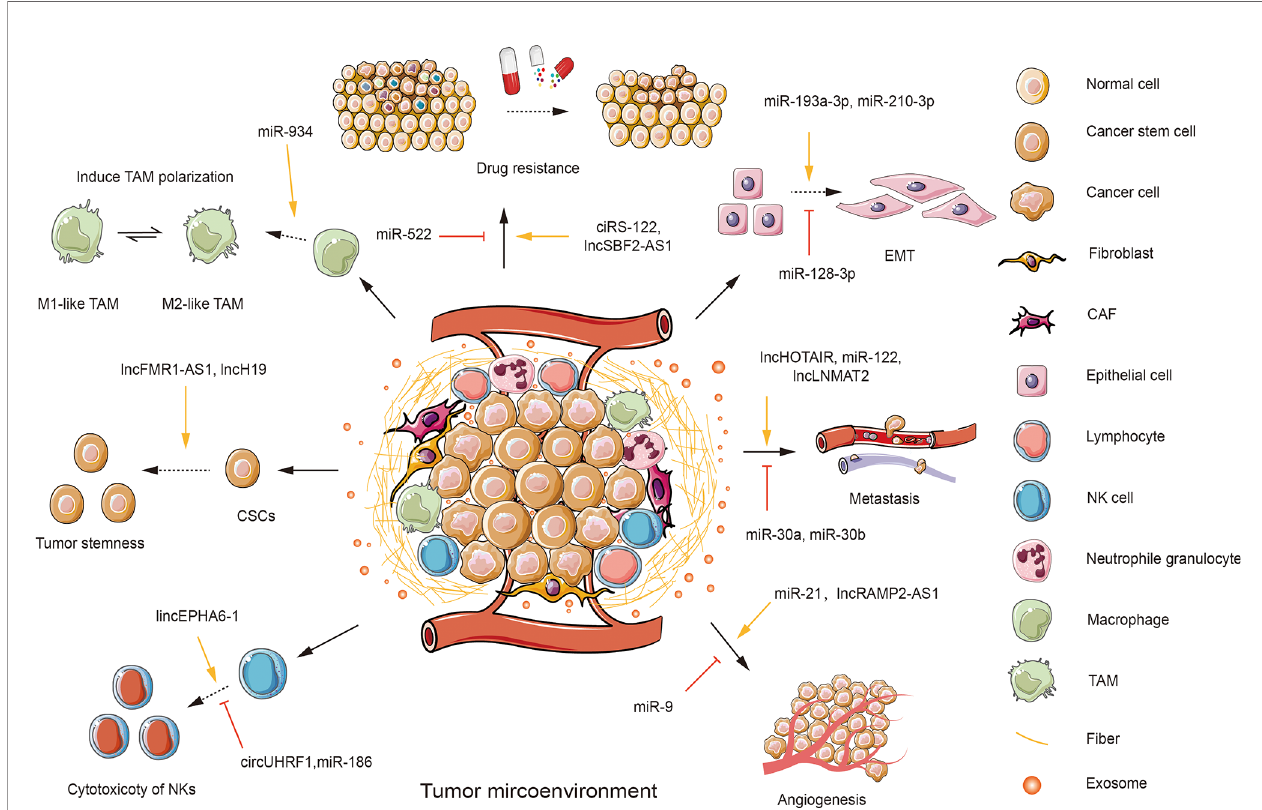
FIGURE 2 | An overview of the roles of exosomal ncRNAs in the tumor microenvironment (TME). TME is composed of various components, including stromal cells, such as fi broblasts; immunity cells, such as T and B lymphocytes, natural killer cells (NKs), neutrophile granulocytes, macrophages; cancer cells; cancer stem cells (CSCs); cancer-associated cells, such as cancer-associated fi broblasts (CAFs) and tumor-associated macrophages (TAMs); and other in fi ltrated biomolecules, such as exosomes. Tumor cells could transfer functional exosomal ncRNAs to regulate the behaviors of recipient cells in the TME. Tumor-derived exosomal miR-934 can induce the polarization of TAMs. Several exosomal ncRNAs can suppress the cytotoxicity of NKs (e.g., circUHRF1 and miR-186). While some exosomal ncRNAs are shown to enhance the cytotoxicity of NKs (e.g., lincEPHA6-1). Some exosomal ncRNAs (e.g., lncFMR1-AS1 and miR-454) can enhance tumor stemness. Additionally, a few exosomal ncRNAs are involved in the regulation of tumor progression. Some exosomal ncRNAs can promote (e.g., miR-21 and lncRAMP2-AS1) or inhibit tumor angiogenesis (e.g., miR-9). Tumor-derived exosomes can transfer exosomal ncRNAs to induce (e.g., lncHOTAIR and miR-122) or suppress (e.g., miR-30a and miR-30b) tumor metastasis. Many exosomal ncRNAs play a role in facilitating (e.g., miR-193-3p and miR-210-3p) or repressing (e.g., miR-128-3p) epithelial-mesenchymal transition (EMT). Several exosomal ncRNAs are involved in promoting tumor drug resistance (e.g., ciRS-122 and